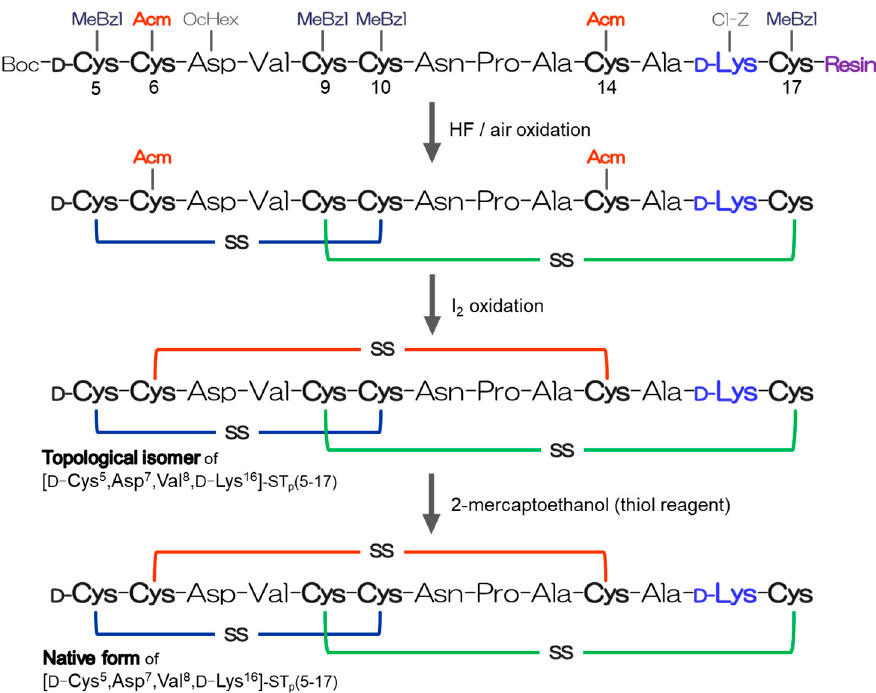
Figure 2. Scheme showing the synthesis of the [ D -Cys 5 ,Asp 7 ,Val 8 , D -Lys 16 ]-ST p (5-17) peptides with the correct disulfide bonds.